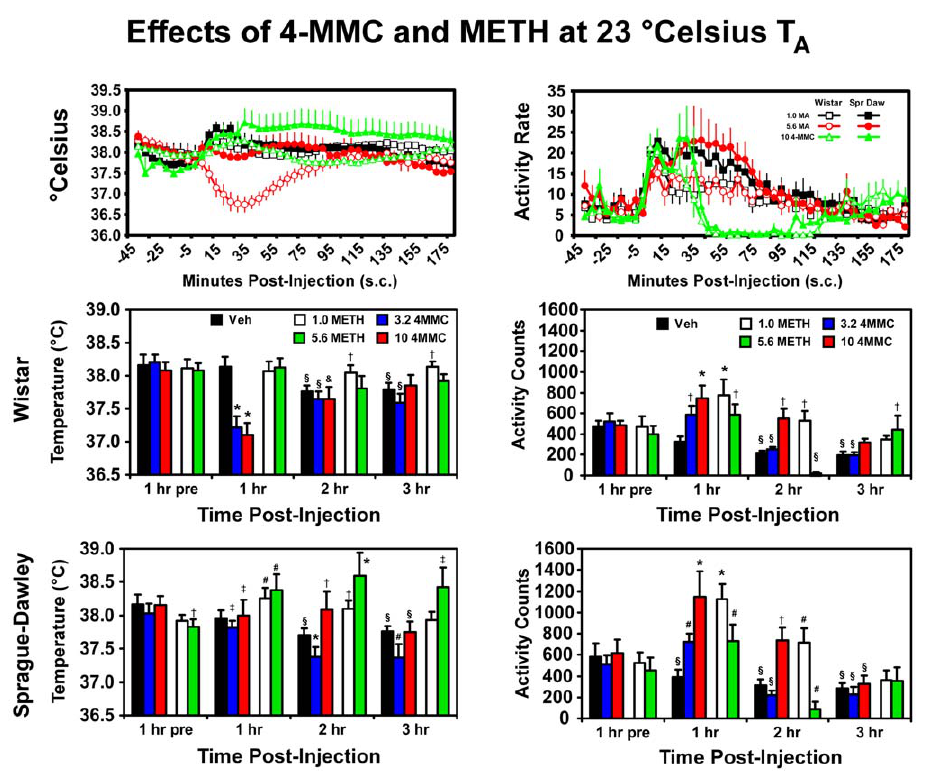
Figure 3. Mean ( ± SEM) body temperature and activity data are presented for Wistar (N=7) and Sprague-Dawley (N=8) rats following challenge with vehicle, d-methamphetamine (1.0, 5.6 mg/kg, s.c.) and 4-MMC (3.2, 10.0 mg/kg, s.c.) under 23 6 C T A . Data were collected at 5 minute intervals (upper panels) and were statistically analyzed as hourly averages. All other statistical conventions are as outlined in Figure